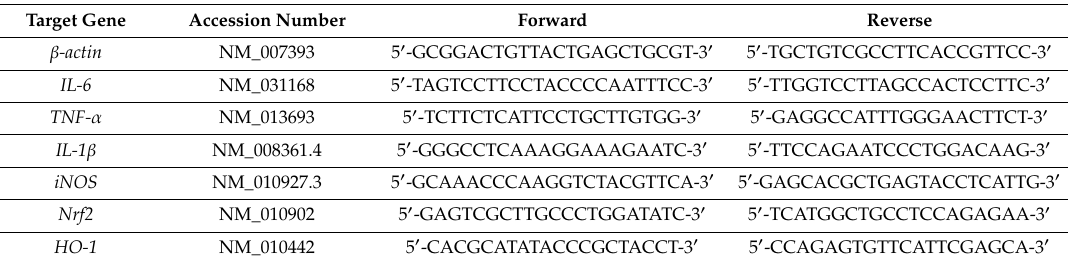
Table 1. Specific primers sequence for RT-qPCR.